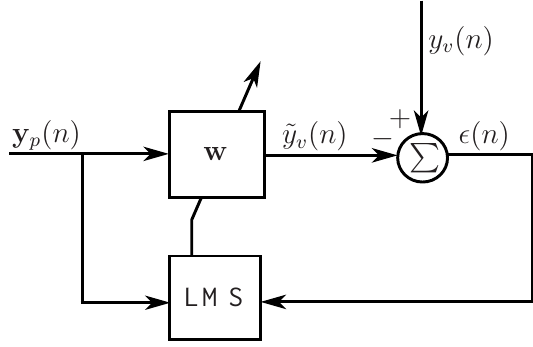
Figure 7 . Block diagram of the adaptive LMS algorithm used to calculate the physical sensor